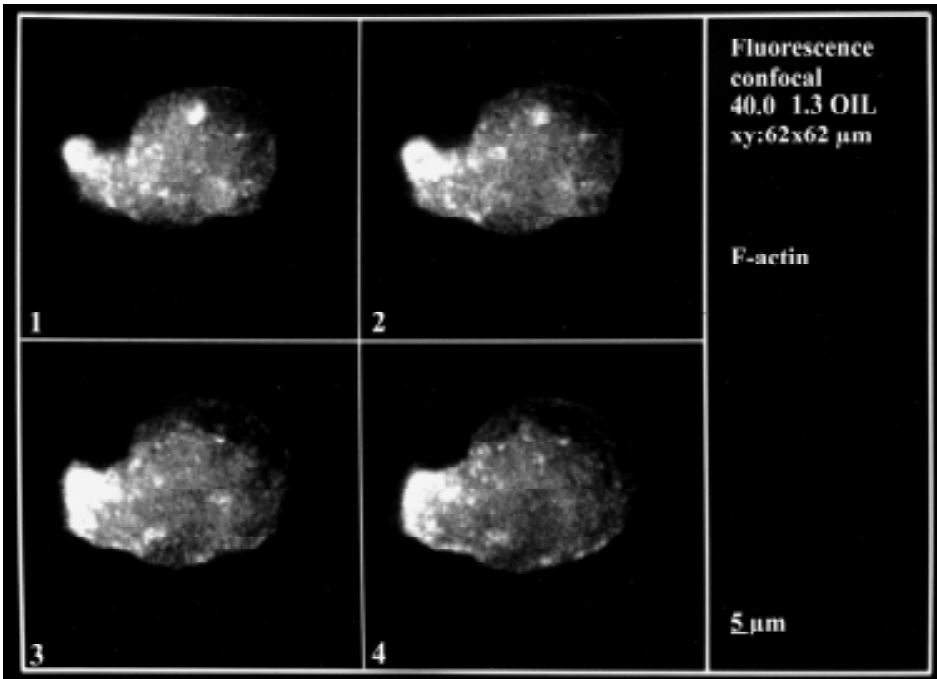
Figure 3 - Actin staining in the leading pseudopod of a tropho- zoite of E. histolytica . Tropho- zoites were seeded in PBS on an acetone-washed coverslip, fixed with paraformaldehyde and permeabilized with Triton X- 100 before labeling amebic fila- mentous actin with Bodipy-phal- loidin. The amebae were then subjected to confocal micros- copy. The first panel shows a section closest to the coverslip upon which the ameba is fixed with successive panels ‘ascend- ing’ through the ameba at inter- vals of 0.5 µm. Courtesy of Dr. Nancy